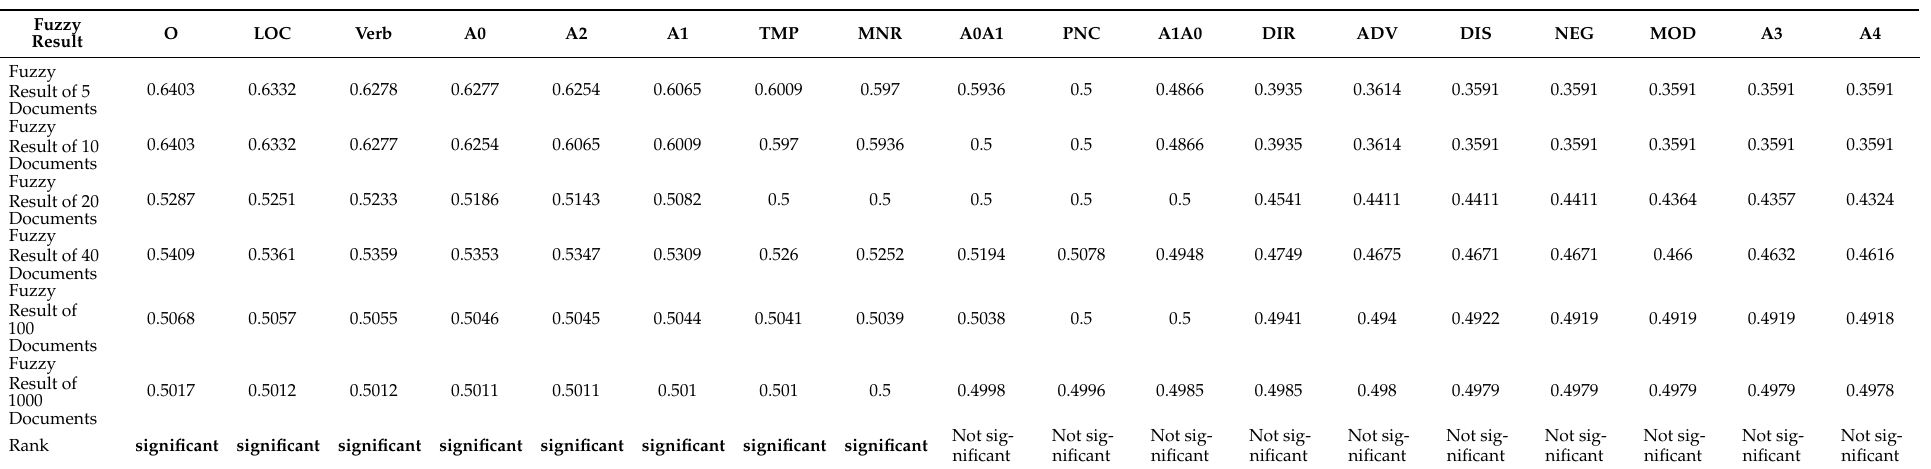
Table 2. Ranking of SRL arguments using